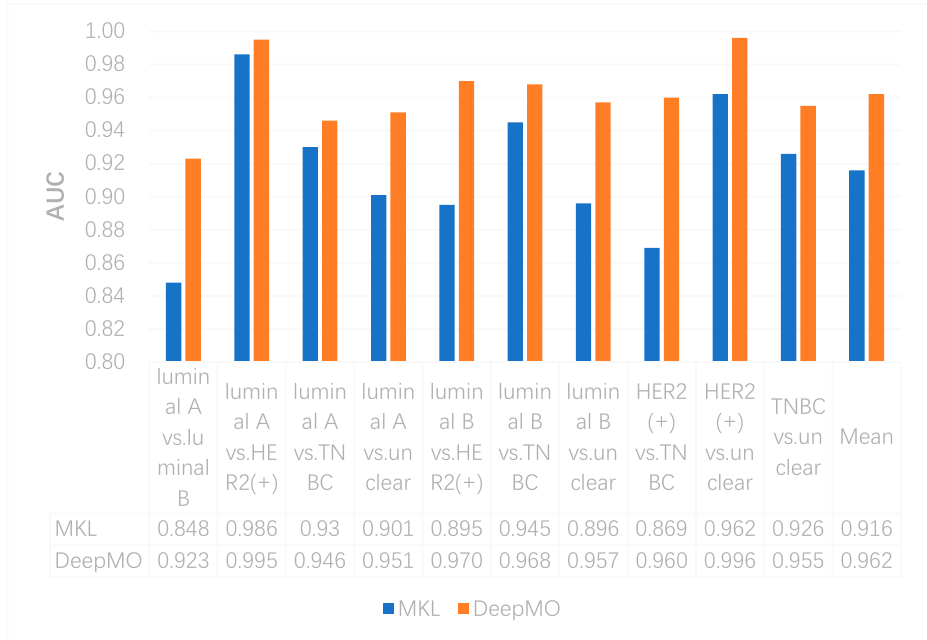
Figure 2. The accuracy by using multiple kernel learning (MKL) and DeepMO on binary classification.